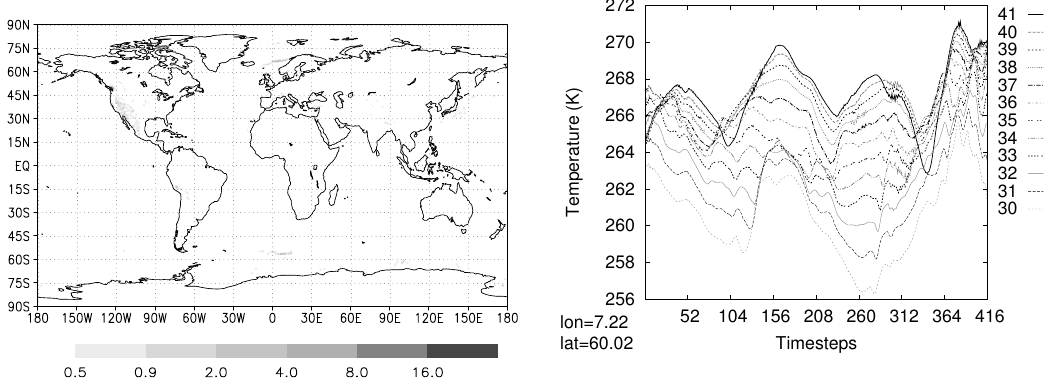
Fig. 8. The left figure shows the amplitude of 2∆ t temperature oscillations on the lowest model level (in Kelvin) after 96 hour forecast computed according to Equation 9 for the model run with the fibrillation amplification test of the large scale precipitation scheme but when the evaporation of precipitation is switched off. The figure on the right shows temperature (in Kelvin) in one model point on the 12 lowest model levels for each time-step during the 96 hour forecast for the model run with the fibrillation amplification test of the large scale precipitation scheme but when the evaporation of precipitation is switched off.